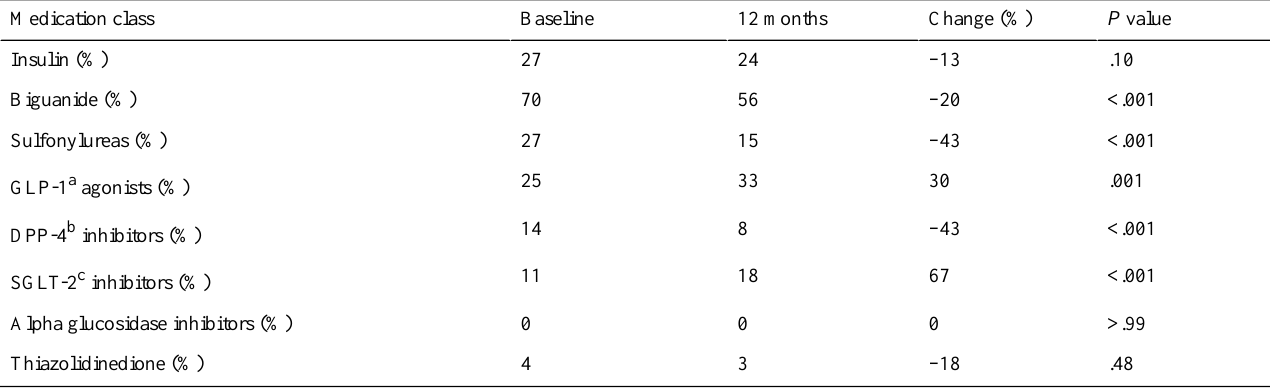
Table 6. Changes in diabetes medications over 12 months of digital medicine management.